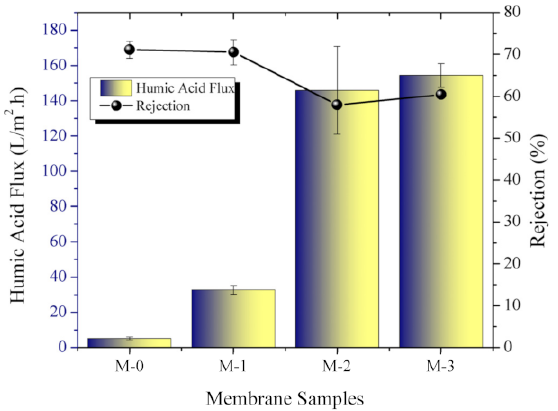
Figure 6. Humic acid flux and rejection of each membrane sample.